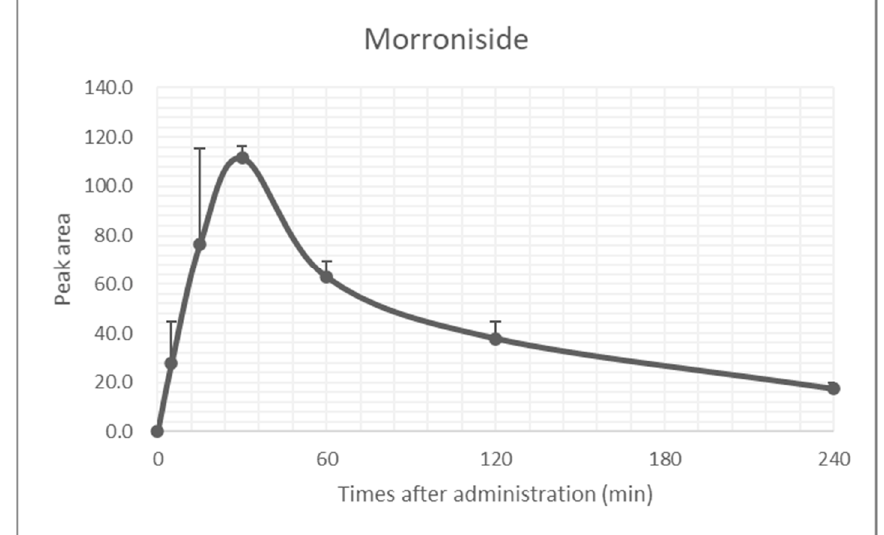
Figure 7. Metabolomic profile of morroniside in mice. Mean plasma concentration–time curves of morroniside in mice after a single administration (5 mg/kg). The data are presented mean ± standard error of the mean (SEM) ( n = 3).